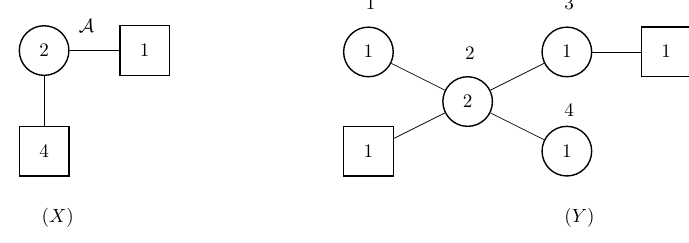
Figure 27 . Mirror duals involving a D 4 quiver on one side. This dual pair ( X, Y ) will be our starting point for arriving at the duality in figure 26. The dual pair can, in turn, be obtained from a pair of linear quivers as discussed in section